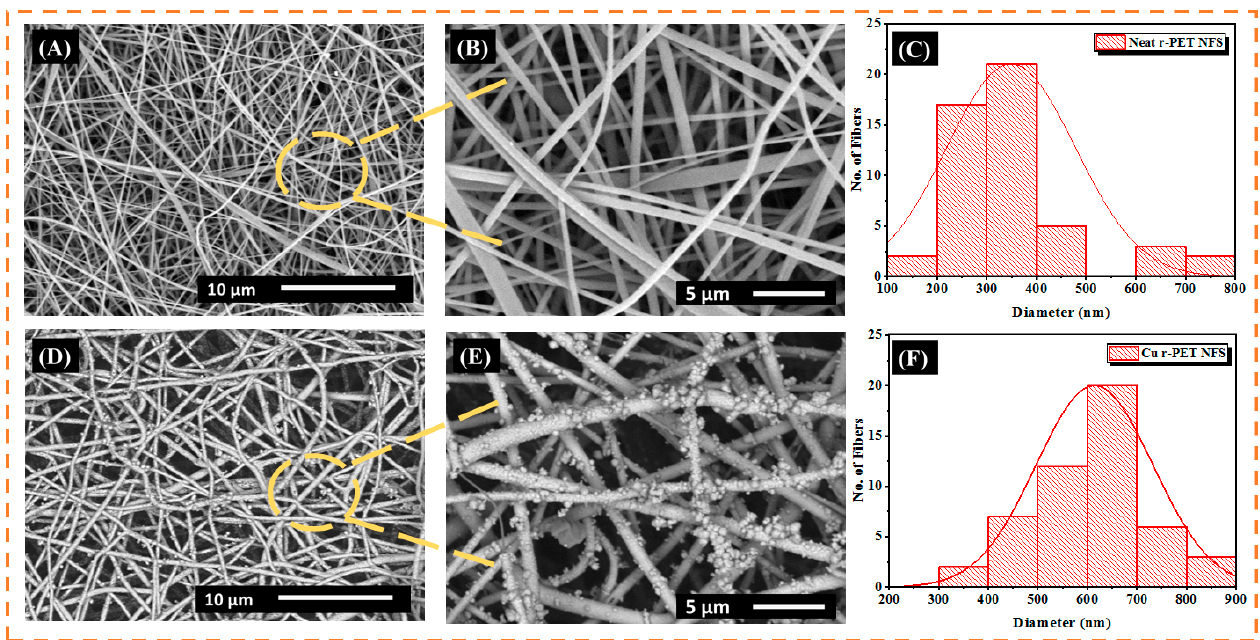
Figure 1. ( A ) SEM image of neat recycled polyethylene terephthalate (r-PET) nanofibers; ( B ) magnified SEM image of neat r-PET nanofibers; ( C ) diameter distribution of neat r-PET nanofibers; ( D ) SEM images of copper-coated r-PET nanofibers; ( E ) magnified SEM image of r-PET nanofibers; and ( F ) diameter distribution of copper-coated r-PET nanofibers.